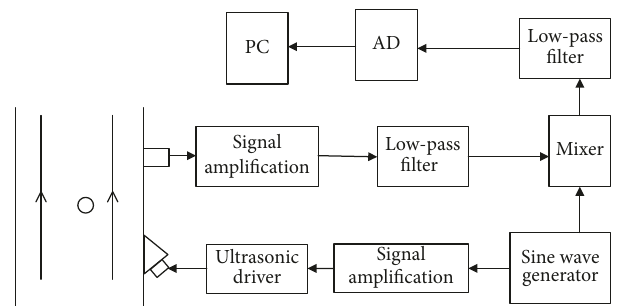
Figure 8: Layout design of the overall detection devices.